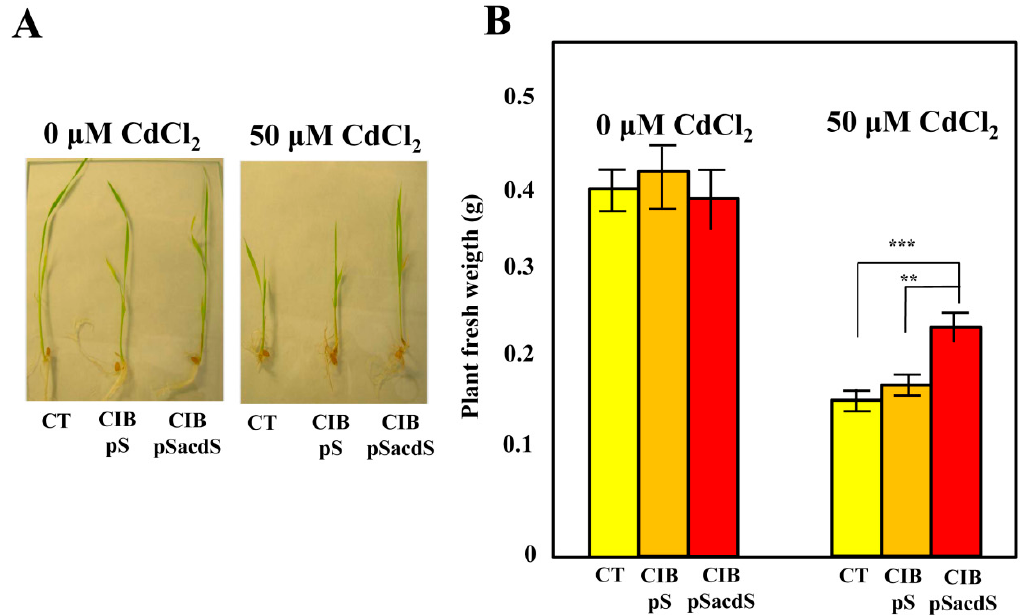
Figure 3. Analysis of the ability of Azoarcus sp. CIB producing ACC deaminase to protect rice against the stress induced by Cd exposure. ( A ) Seedlings of rice obtained after inoculation with Azoarcus sp. CIB (pSEVA237) (CIB pS) (red column), Azoarcus sp. CIB (pSEVA237acdS) (CIB pSacdS) (orange column), or without bacteria (CT) (yellow column), after 10 days of growth in substrates containing 0 µ M or 50 µ M CdCl 2 in greenhouse conditions. ( B ) Rice plants inoculated with Azoarcus sp. CIB (pSEVA237) (CIB pS) (red column), Azoarcus sp. CIB (pSEVA237acdS) (CIB pSacdS) (orange column), or without bacterial inoculation (CT) (yellow column), were grown in substrates containing 0 µ M or 50 µ M CdCl 2 in greenhouse conditions as detailed in Section 2. The total fresh weight of each plant (g) was determined. Presented are mean values for 20 plants with the corresponding errors. The asterisks indicate the statistical significance observed when two conditions were compared applying the Two-ways ANOVA method and the Bonferroni test. p < 0.001 (***); p < 0.01